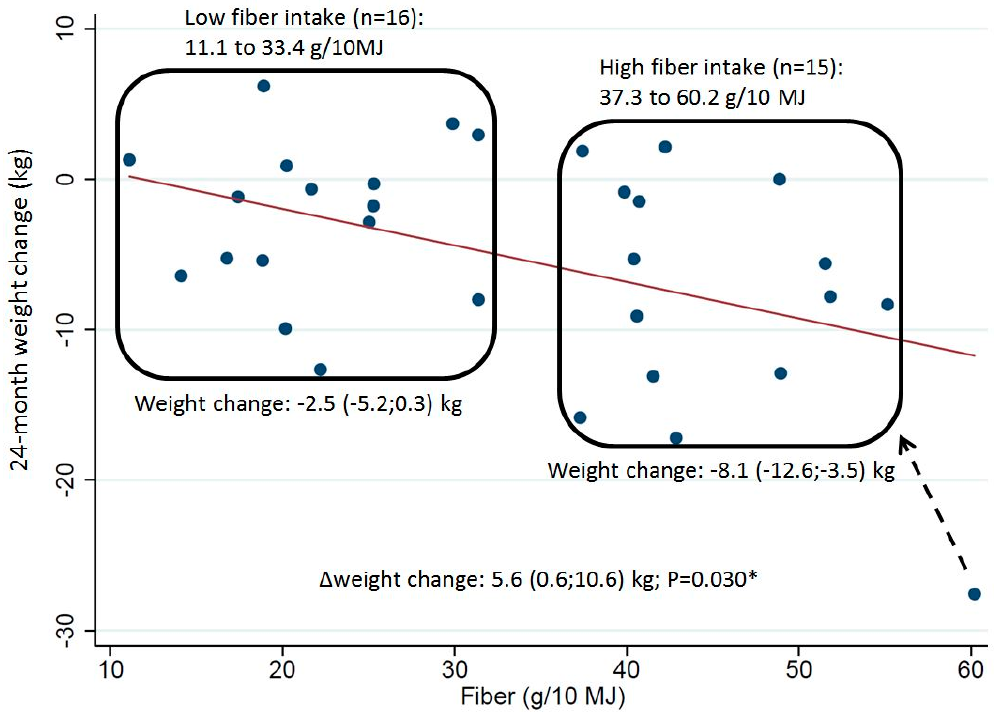
Figure 1. Dietary fiber intake as a function of weight change among subjects with prediabetes and low fasting insulin. Values for fiber intake is reported as range and weight change is reported as mean (95%CI). *Analyzed using t -test. When excluding the one subject with self-reported fiber intake of 60 g/10 MJ the p -value was p = 0.057.